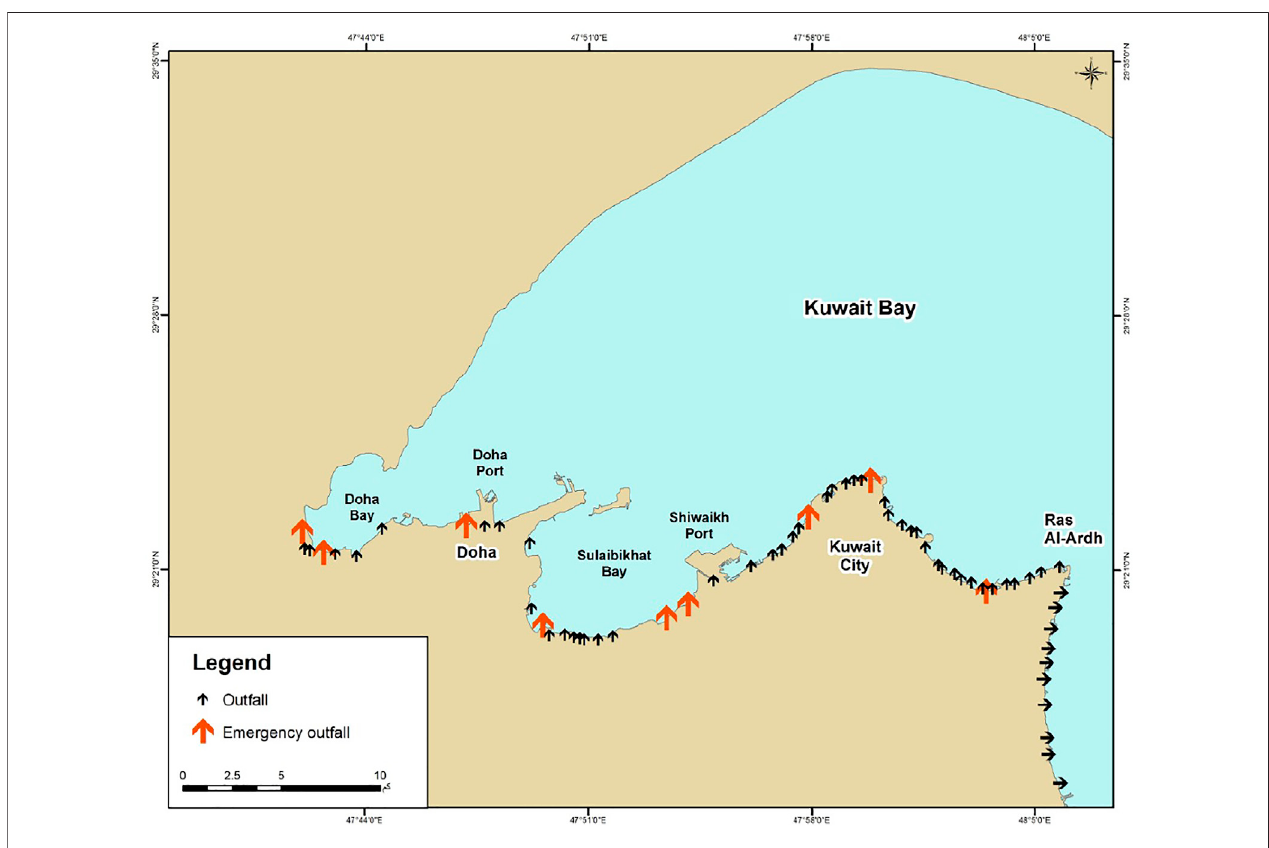
FIGURE 2 | Coastal outfalls along the southern coast of Kuwait